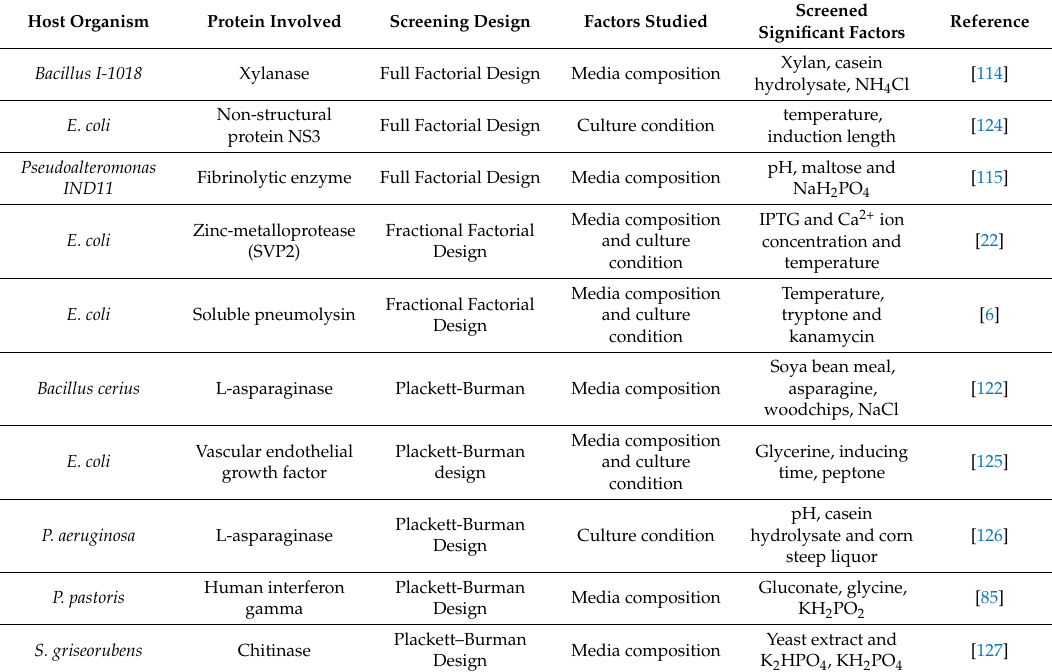
Table 4. A selection of the widely used screening designs and their application in identifying the influential factors on the production of recombinant proteins.